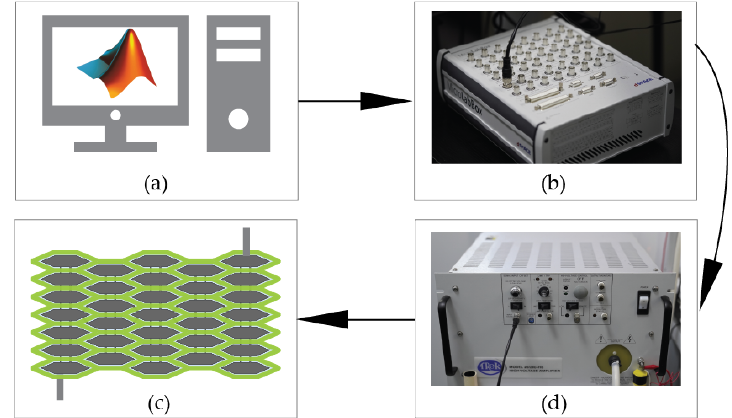
Figure 7. The experimental setup: ( a ) Simulink; ( b ) dSPACE; ( d ) amplifier; ( c ) actuator prototype.